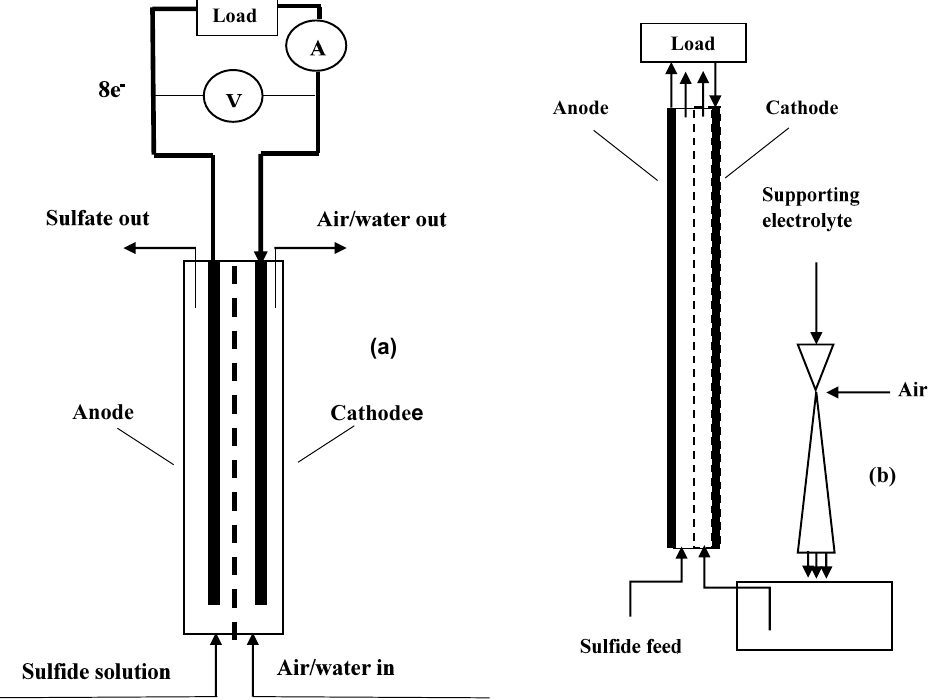
Figure 9. A sketch of the fuel cell discharge assembly with direct aeration ( a ); the aeration system with Venturi tube ejector ( b ).